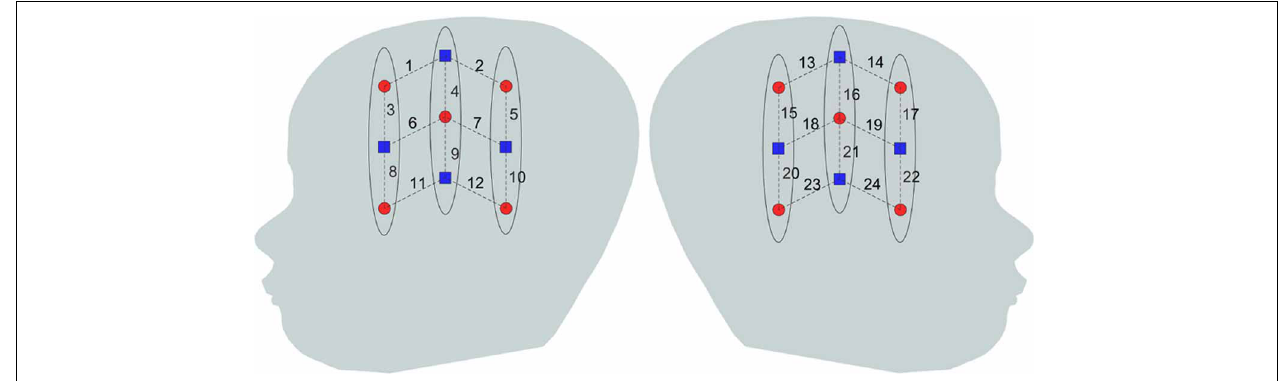
FIGURE 2 | Optode placement on the head. Blue squares and red dots indicate detectors and sources, respectively while the dashed lines indicate the measurement channels and the numbers indicate the channel number.